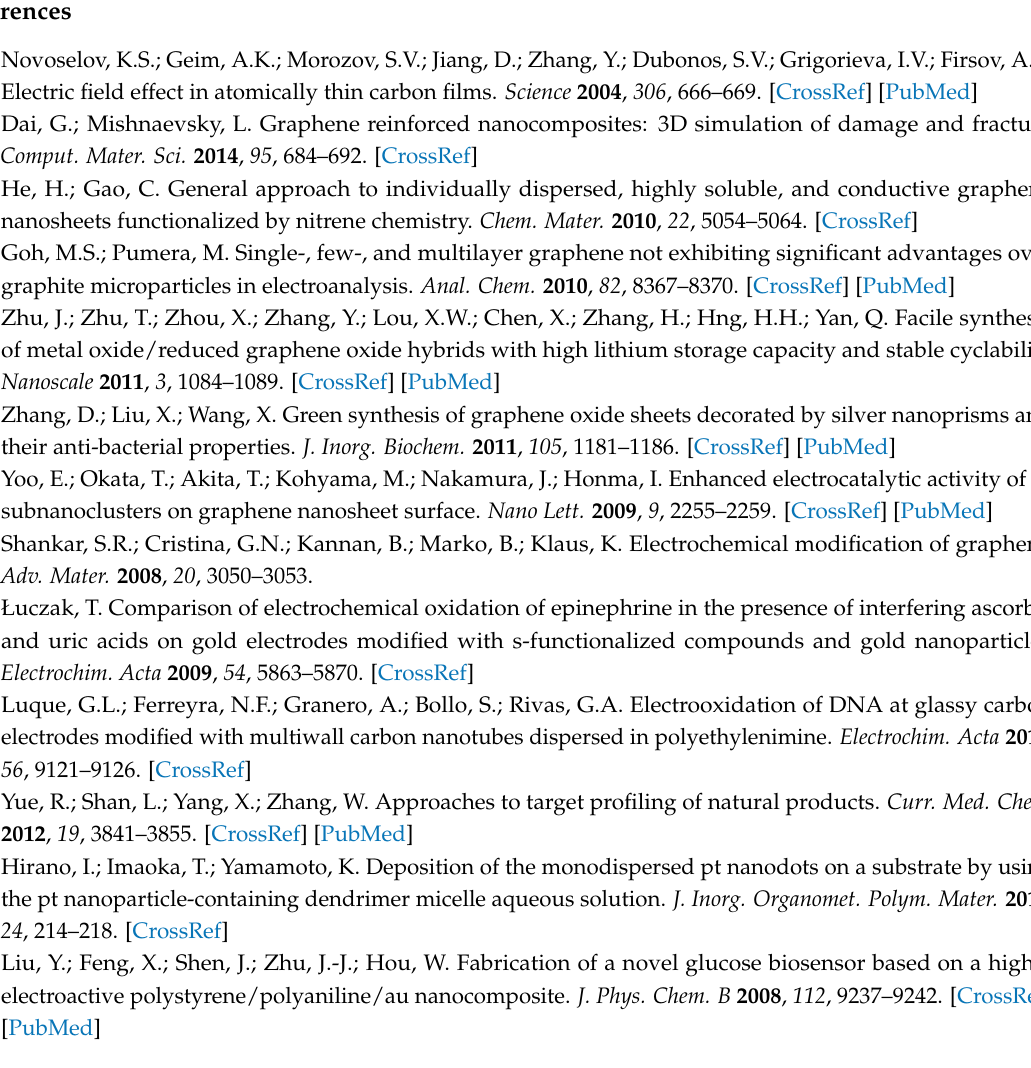
Figure S1: FT-IR patterns of GO (a) and BLG-PtAuPd-RGO (b), Figure S2: Synthetic composite materials with BLG (B) and without BLG (A) in a static position at indoor temperature for 48 hours, Figure S3: Amperometric response of GOD-BLG-PtAuPd-RGO/GC electrodes in 0.1 M PBS (PH 7.0) solution mixture at operating voltage of 600 mV with 0.5 mM glucose or other substance: uric acid (0.8 mM), ascorbic acid (0.6 mM) and cholesterol (0.6